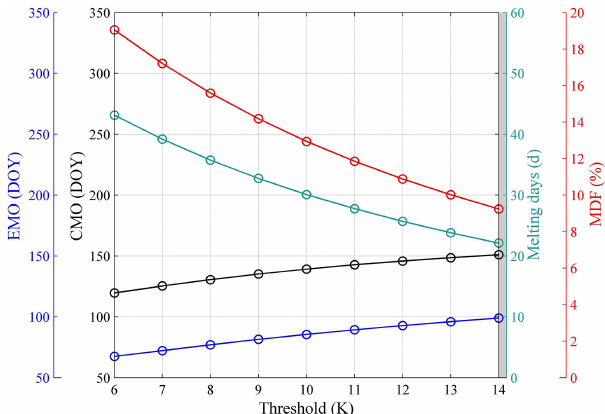
Figure 11. Annual mean EMO (blue dots), CMO (black dots), melt- ing days (cyan dots) and MDF (red dots) with the threshold for AMSR-E/2 DAV36 varying from 6 to